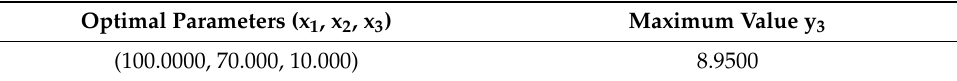
Table 6. The results of the optimization problem for y